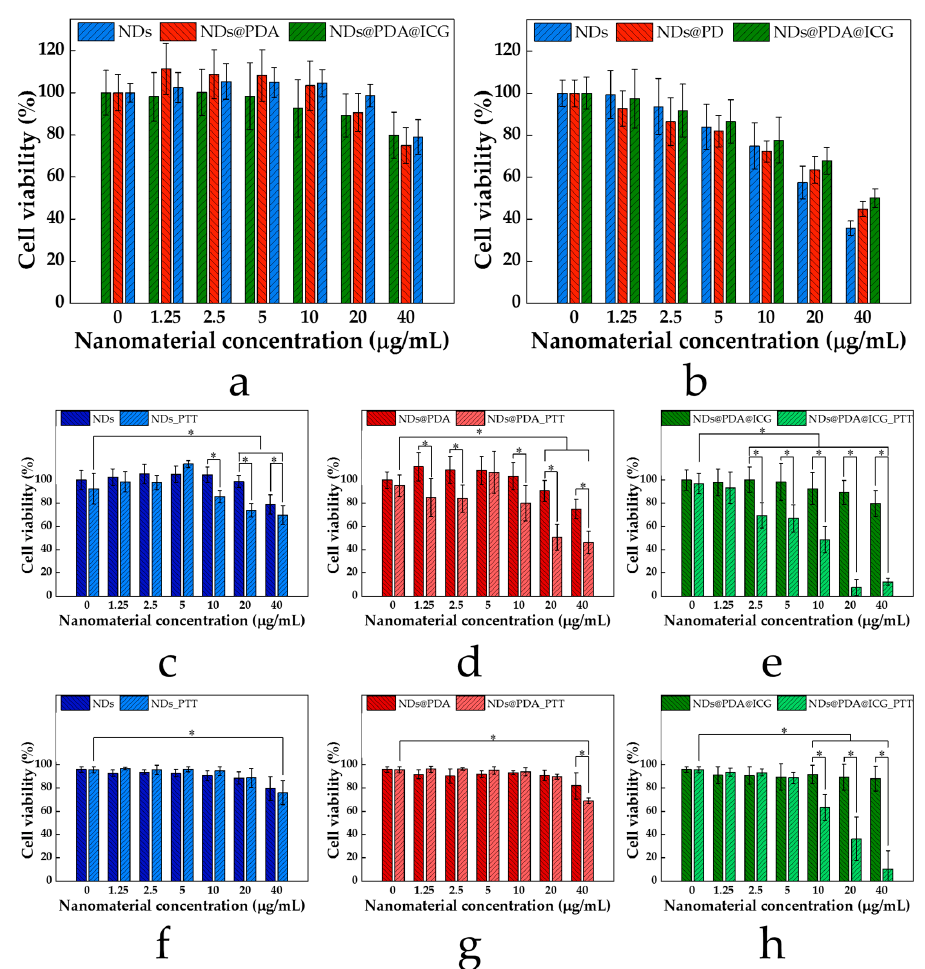
Biomimetics 2019 , 4 , x FOR PEER REVIEW 13 of 18 Figure 6. WST-1 viability results of NDs-based clusters in ( a ) U-118 MG and ( b ) MSU 1.1 cells. ( c – e ) WST-1 cell viability with and without laser irradiation. ( f – h ) Count and viability assay results of NDs-based clusters with and without laser irradiation. Error bars represent the standard deviation. *, p -value < 0.05.